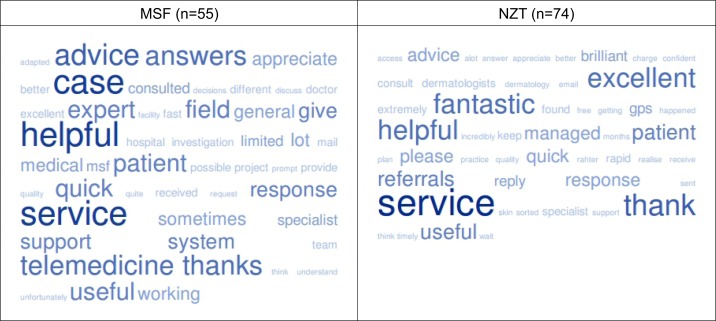
Word frequencies* in the free-text responses to the invitation to comment about the telemedicine service.*See http://tagcrowd.com/.